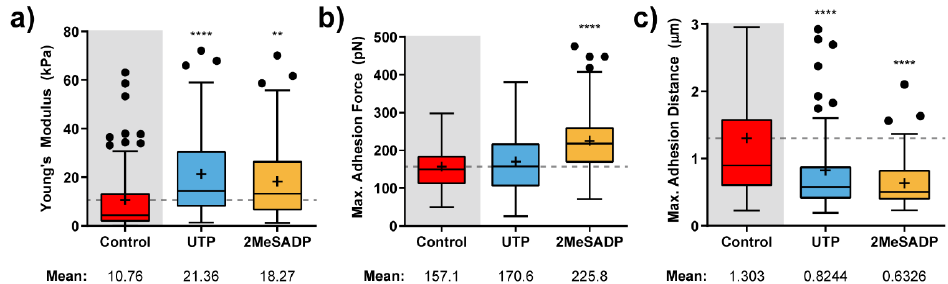
Figure 3. Effects of nucleotide stimulation of cerebellar astrocytes ( N > 30) on the parameters determined with AFM. Calculated Elastic modulus ( a ) and adhesion-related ( b , c ) value variation for astrocytes exposed to 100 µ M UTP (blue), and 10 µ M 2MeSADP (yellow) agonists. Boxplots cover the range 25–75%, being the horizontal line indicative for the median, and the cross for the mean value, which are shown numerically below. For comparative purposes, a horizontal dashed grey line indicates control mean values. Whiskers indicate 5 and 95%, while black dots refer to outliers. Statistically relevant variations p < 0.01 and p < 0.0001 are highlighted by ** and ****, respectively.